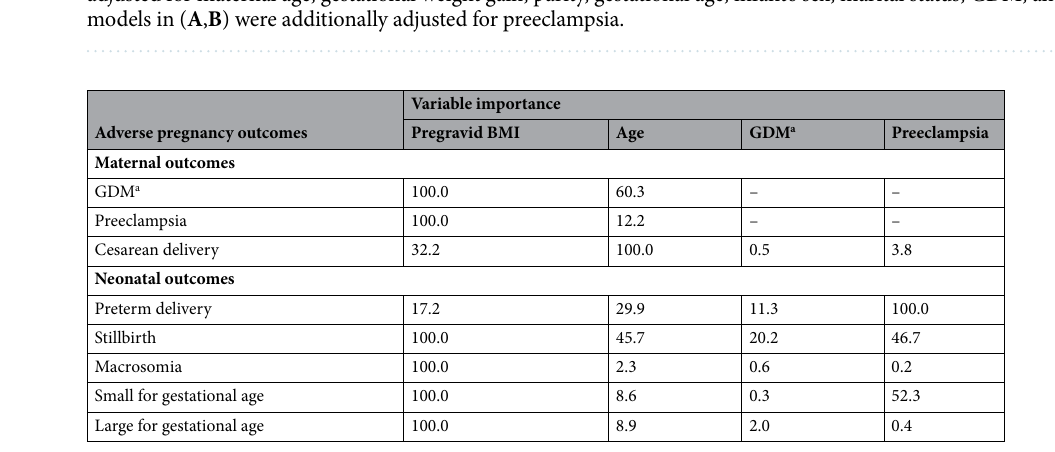
Figure 2. Pre-gestational BMI and risks of infant outcomes stratified by maternal age. Figures ( A – E ) show the age specific odds ratio and 95% confidence intervals for pre-pregnancy BMI on infant outcomes. Models were